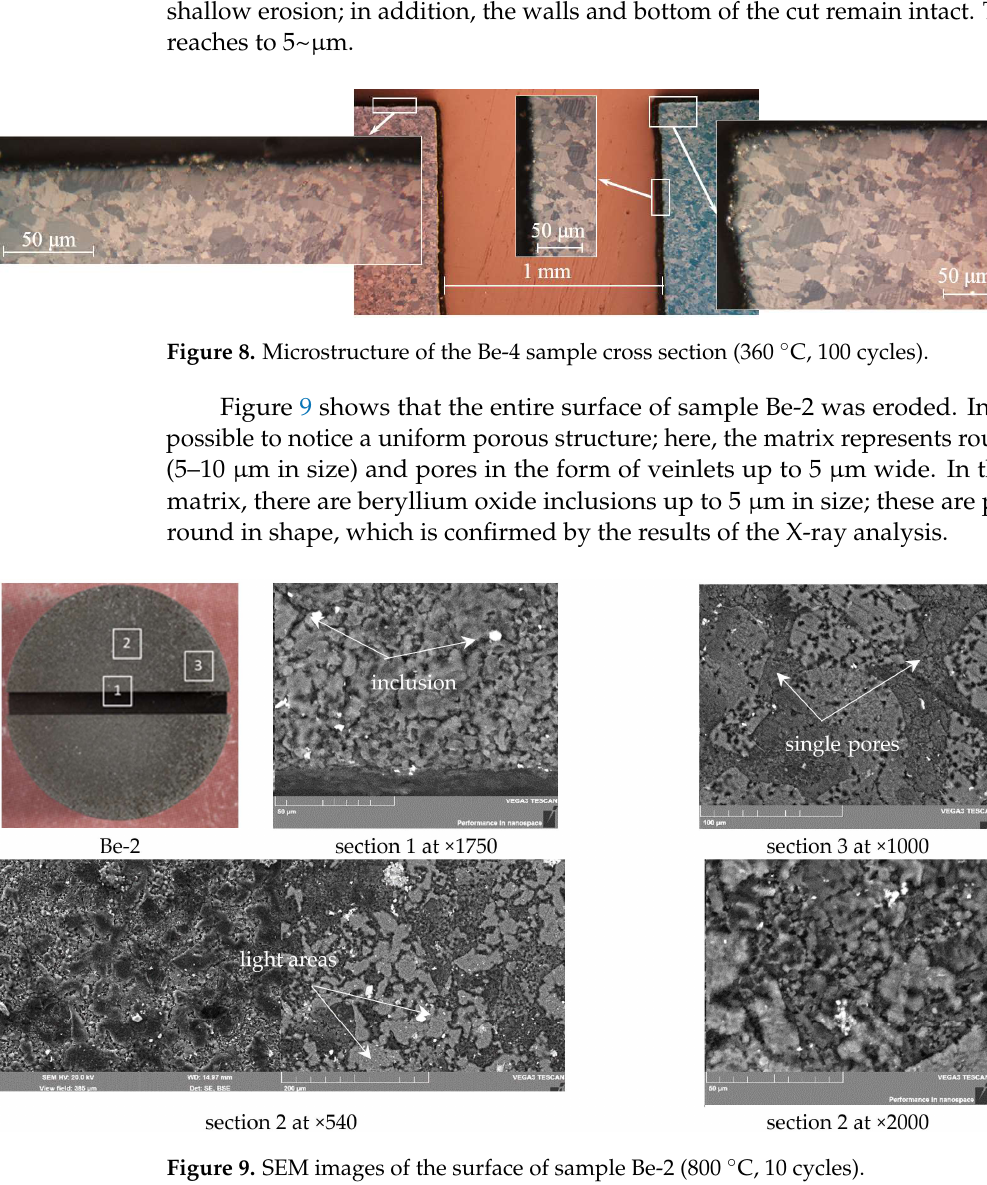
Figure 7. SEM images of the sample Be-4 surface (360 °С, 100 cycles).